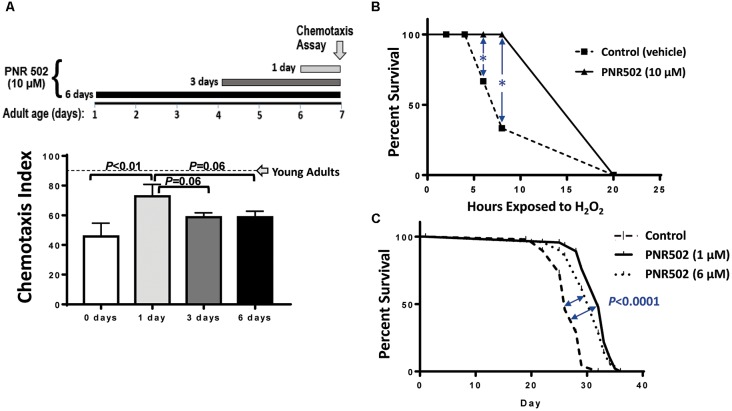
PNR502 reduces neurotoxicity, sensitivity to oxidative stress, and mortality in C. elegans. (A)
C. elegans adult worms (strain CL2355, without induction), a model of Alzheimer’s disease (AD)-like amyloidosis, were treated with 10-μM PNR502 for 1, 3 or 6 days just prior to assaying chemotaxis towards n-butanol. Worms treated for 1 day differ from controls at P < 0.01 (histogram). Worms treated 3 or 6 days differ from controls at P < 0.05, and may also differ from the 1-day treatment group (P = 0.06). Error bars show standard deviations. The dashed line indicates normal chemotaxis of uninduced adults at day 1. (B)
C. elegans wild-type worms (Bristol-N2 [DRM]) were exposed to 10-μM PNR502 or vehicle alone (controls) and monitored for survival during exposure to 5-mM hydrogen peroxide as an oxidative stress. *Significance of survival differences at 6 and 8 h, by two-sided t-test: P < 0.01. (C) Worms exposed to 1- or 6-μM PNR502, or vehicle alone, were monitored for survival at 20°C under benign conditions to assess lifespan. Significance of survival-curve differences, by Gehan-Wilcoxon log-rank tests: P < 0.05 for stress response (B, each N = 30), and P < 1E-4 for lifespan (C, each N = 40). Data displayed were combined from two independent experiments of each type (B,C).